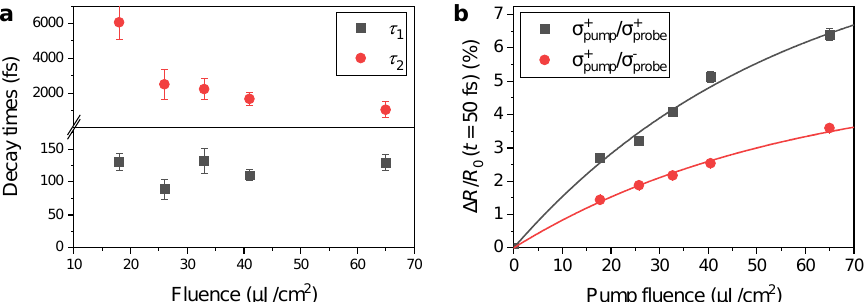
Figure 4. ( a ) Decay times τ 1 and τ 2 from the double exponential fits of the valley polarization dynamics shown as dashed curves in Figure 3. ( b ) The maxima of the transient reflectivity signal as a function of the pump fluence for both combinations of circular polarizations of pump and probe pulses. Curves correspond to fits according to the phenomenological description of absorption saturation (see text for